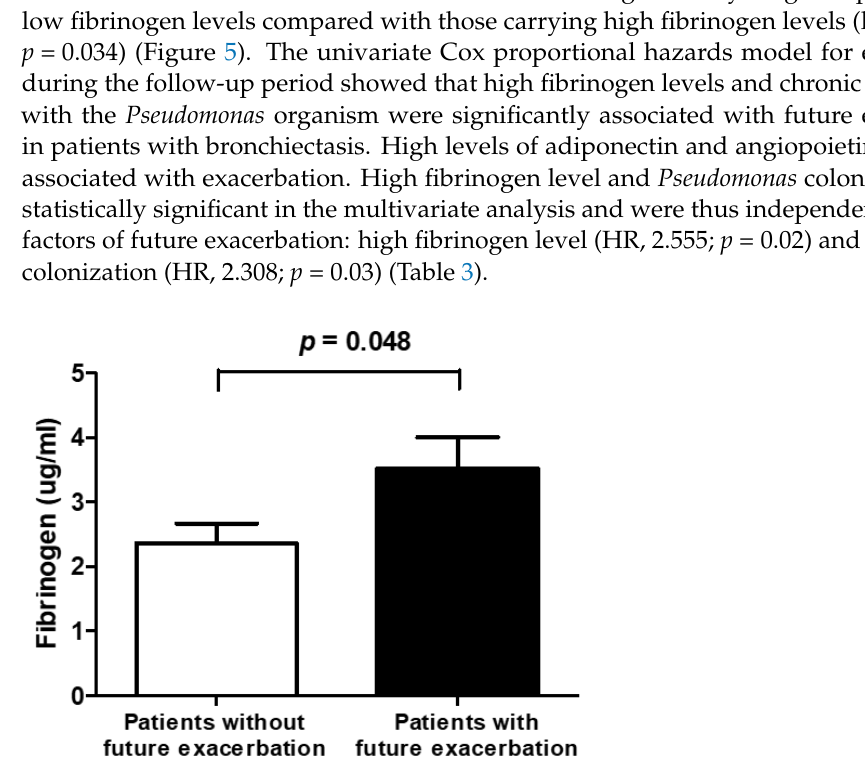
Figure 4. Comparison of fibrinogen levels between patients with and without exacerbation.